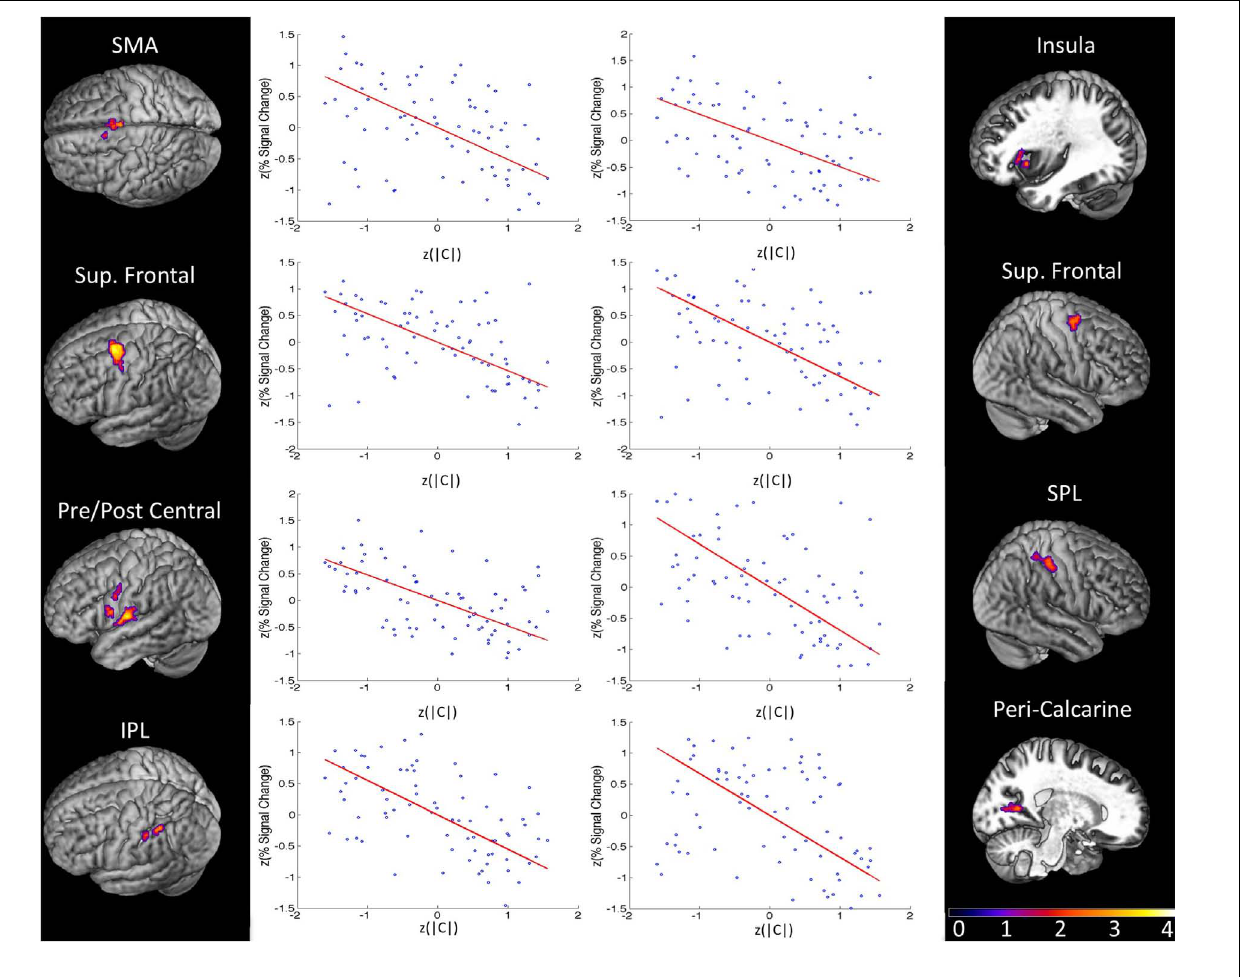
across all voxels in the region). Each plot contains five data points from each of the 15 subjects (blue) corresponding to the five same-different ratio conditions in the syllable discrimination experiment.The orthogonal least squares fit is plotted in red.There is a strong negative relationship between response bias and PSC in every region of this fronto-parietal